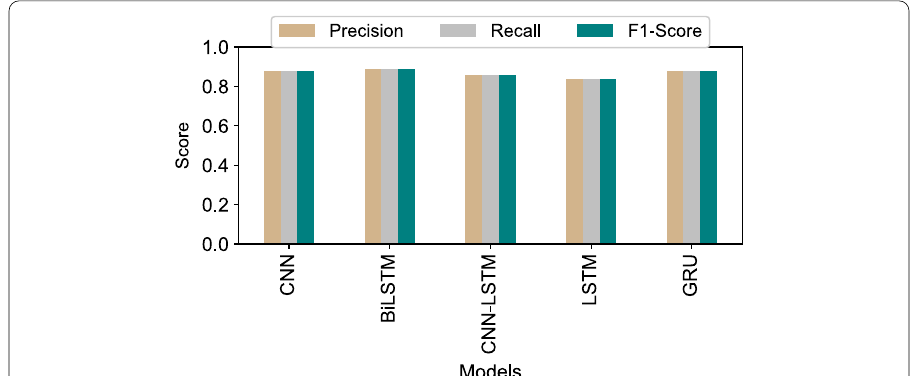
Fig. 3 Weighted average score of deep learning models trained with embedding